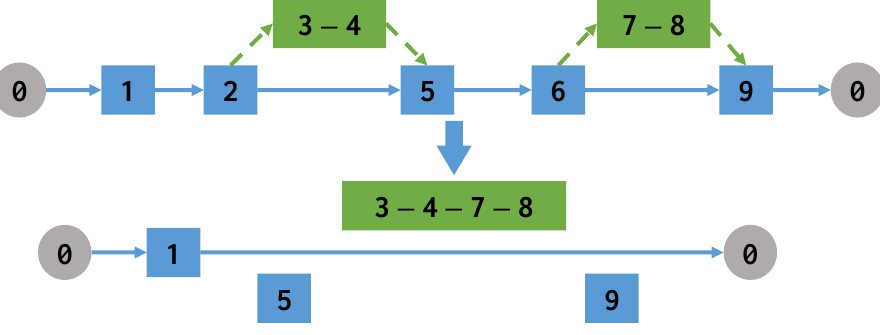
Figure 7. Connect the drone tasks.